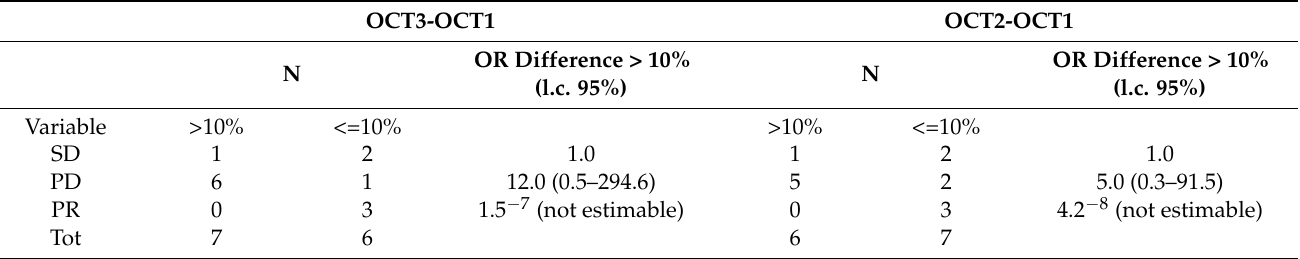
Table 3. OR of significant reduction in pRNFL (>10%) by disease